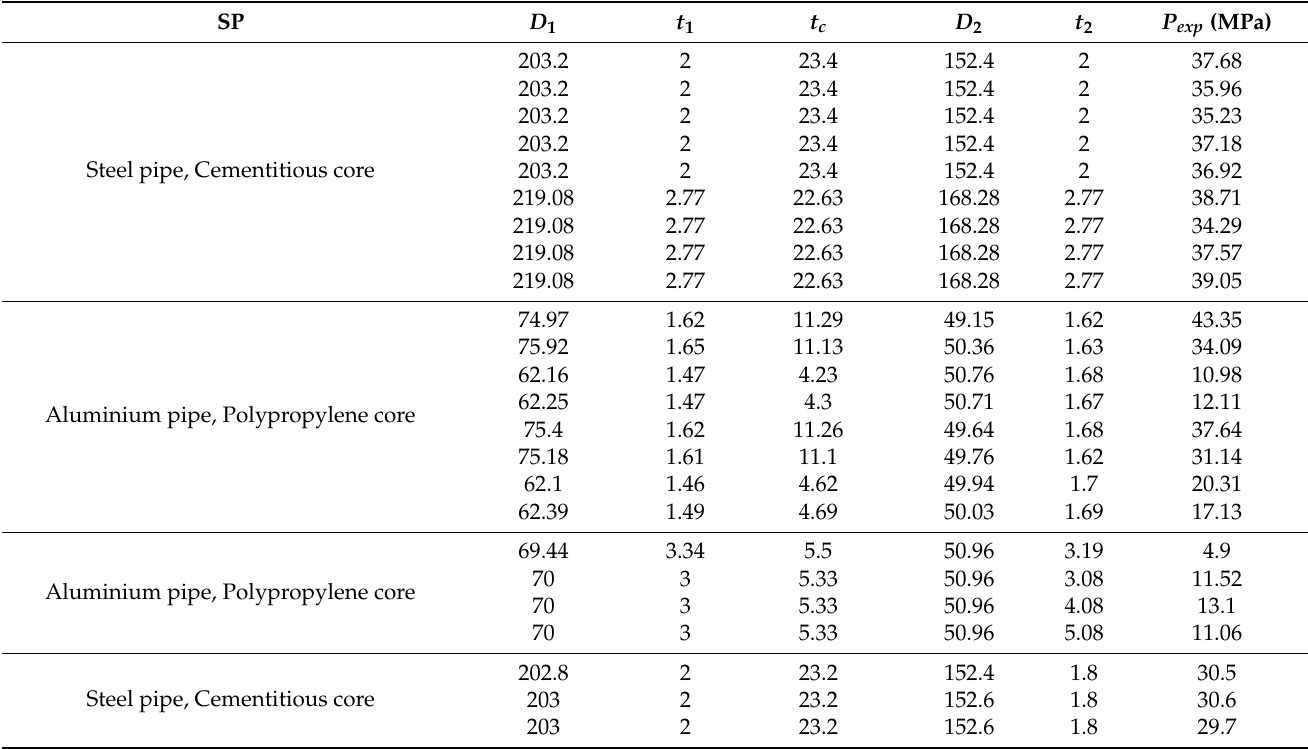
Table A2. Collapse test data of sandwich pipes